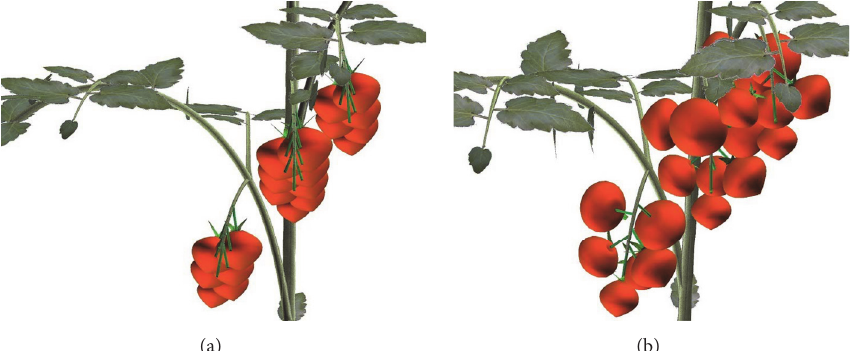
Figure 9: Comparison modeling tomato plant with or without collision detection. (a) Without collision detection. (b) With collision